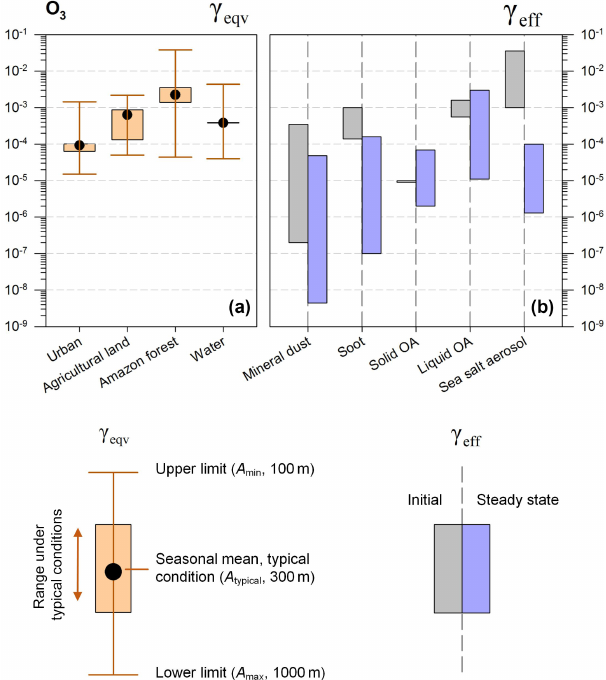
Figure 3. Equivalent uptake coefficients ( γ eqv , a ) and laboratory measurement values ( γ eff , b ) for O 3 on different ground types and aerosols. For γ eqv , the upper whiskers represent maximum values calculated at the lowest A and h ( h = 100m), the lower whiskers represent minimum values calculated at the highest A and h ( h = 1km), and boxes represent typical conditions (typical A as described in Sect. 3.1, h = 300m). For γ eff , the gray bar represents the range of initial values, and the blue bar represents the range of steady-state values observed in laboratory